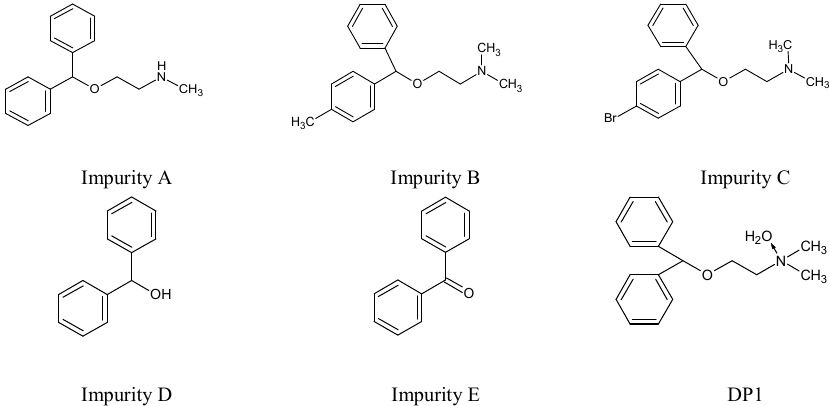
Figure 2. Chemical structures of the related substances of diphenhydramine (DIPH) [14,18].